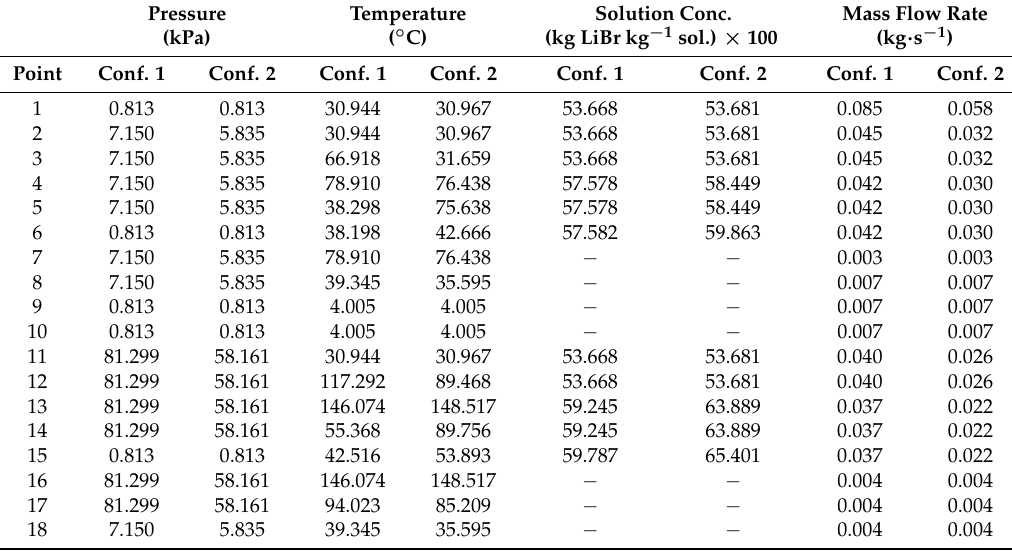
Table 3. Optimal values of operating conditions obtained for configurations Conf. 1 and Conf. 2 for a cooling capacity of 16